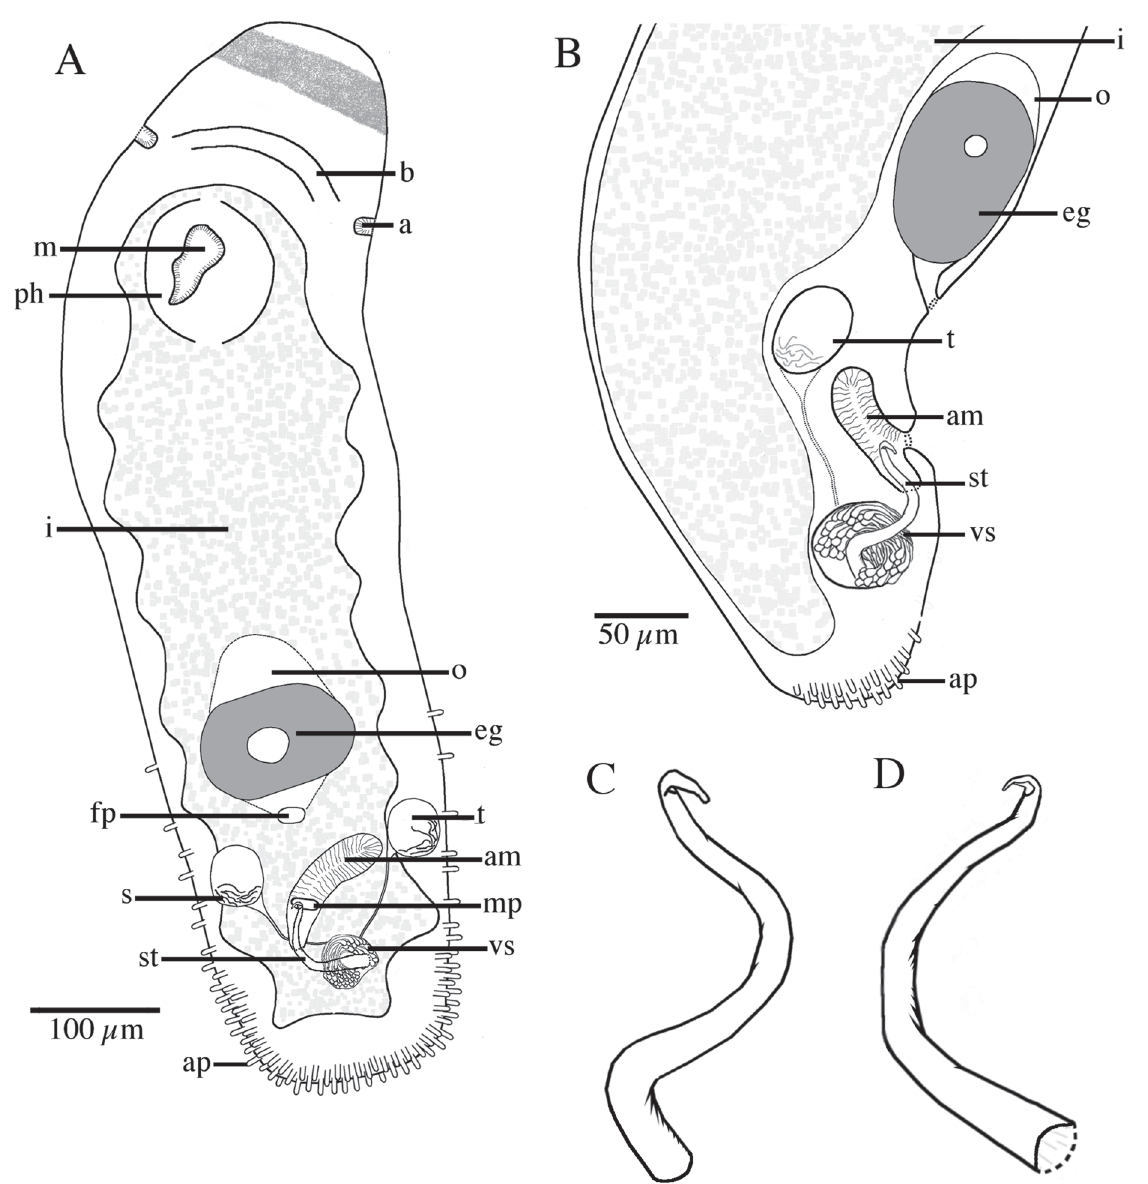
Fig. 5 . Microstomum rubromaculatum von Graff, 1882, composite sketches. A . Ventral view of entire body. B . Lateral view of posterior end. C . Lateral view of stylet. D. Ventral view of stylet. Abbreviations: a = auricles (ciliary pits); am = antrum masculinum; ap = adhesive papillae; b = brain; eg = egg; fp = female pore; i = intestine; m = mouth; mp = male pore; o = ovary; ph = pharynx; s = sperm; st = male stylet; t = testis; vs = vesicula